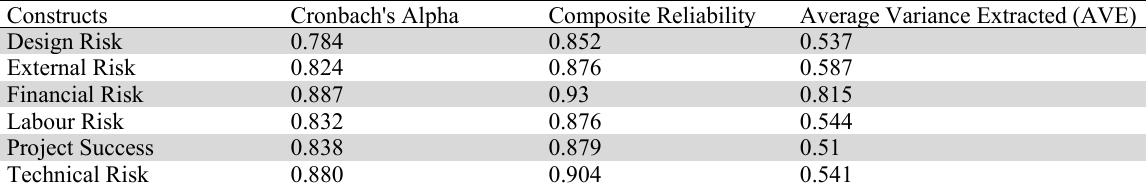
Constructs reliability values Constructs